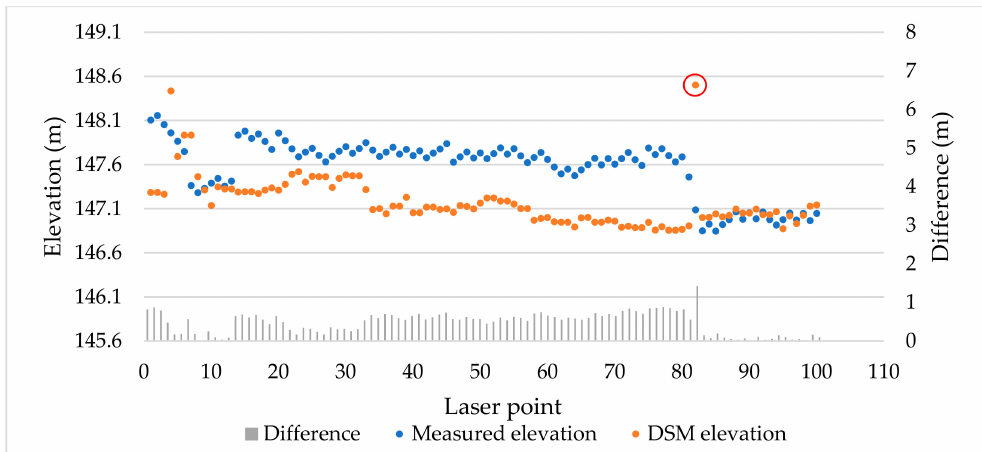
Figure 10. Elevation accuracy verification results for flat terrain. Gray histogram shows the di ff erence between the measured (blue) and digital surface model (DSM, orange) elevation. The red circle is the data error caused by a ground object in the DSM data.